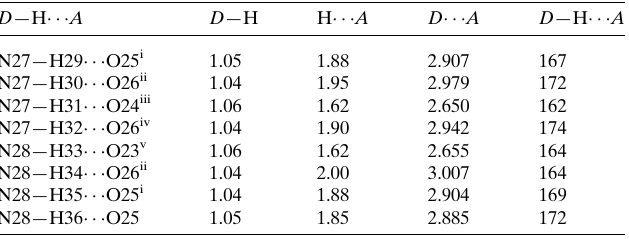
Table 1 Hydrogen-bond geometry (A˚ , (cid:4)